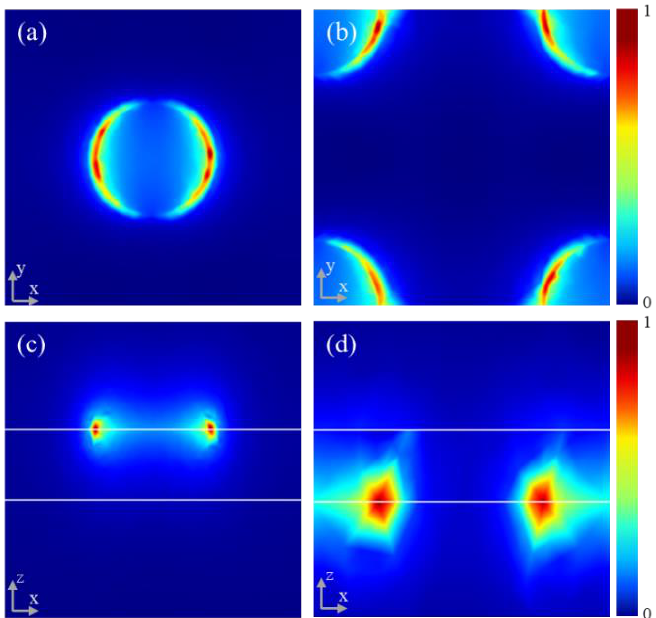
Figure 3. The normalized electric field intensity distribution (x-y incident plane) of ( a ) absorption peak A and ( b ) absorption peak B. The normalized electric field intensity distribution (x-z incident plane) of ( c ) absorption peak A and ( d ) absorption peak B.